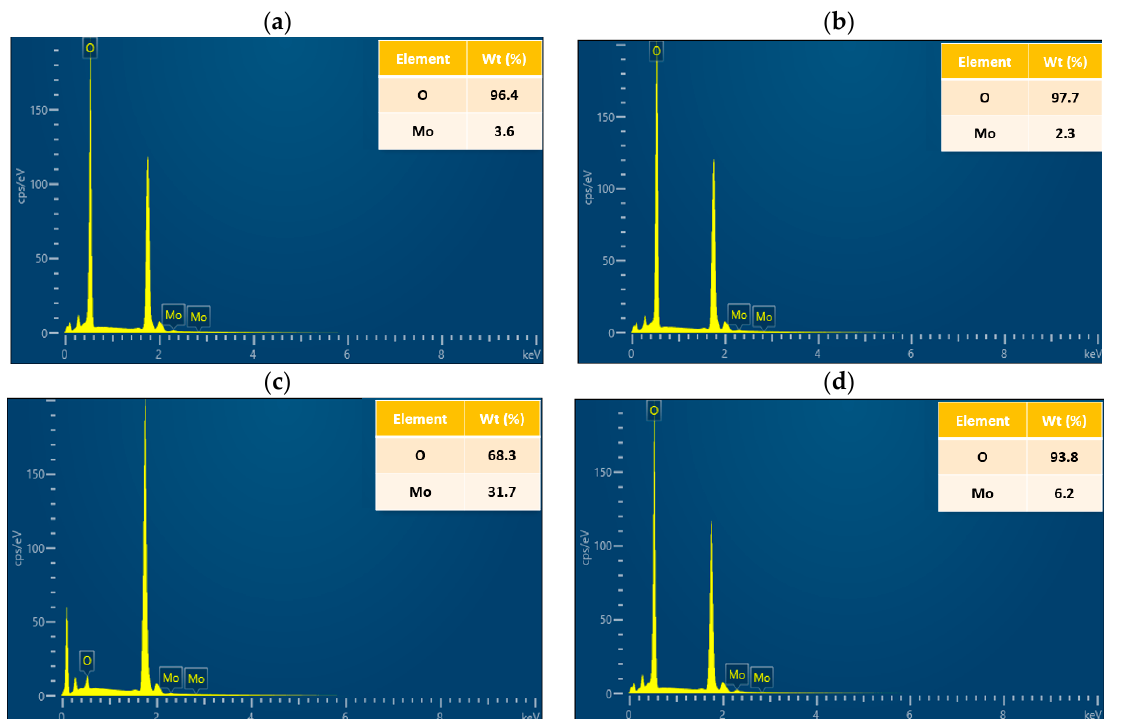
Figure 3. The EDS of MoO 3 /Si samples: ( a ) S1, ( b ) S2, ( c ) S3, and ( d ) S4. The Si peak was ignored in the EDS results because it had almost 99.1% which could disappear the Mo peaks. So, it was hard to detect Mo peaks in the presence of Si, due to the fact that the thickness of the Mo layer was a few